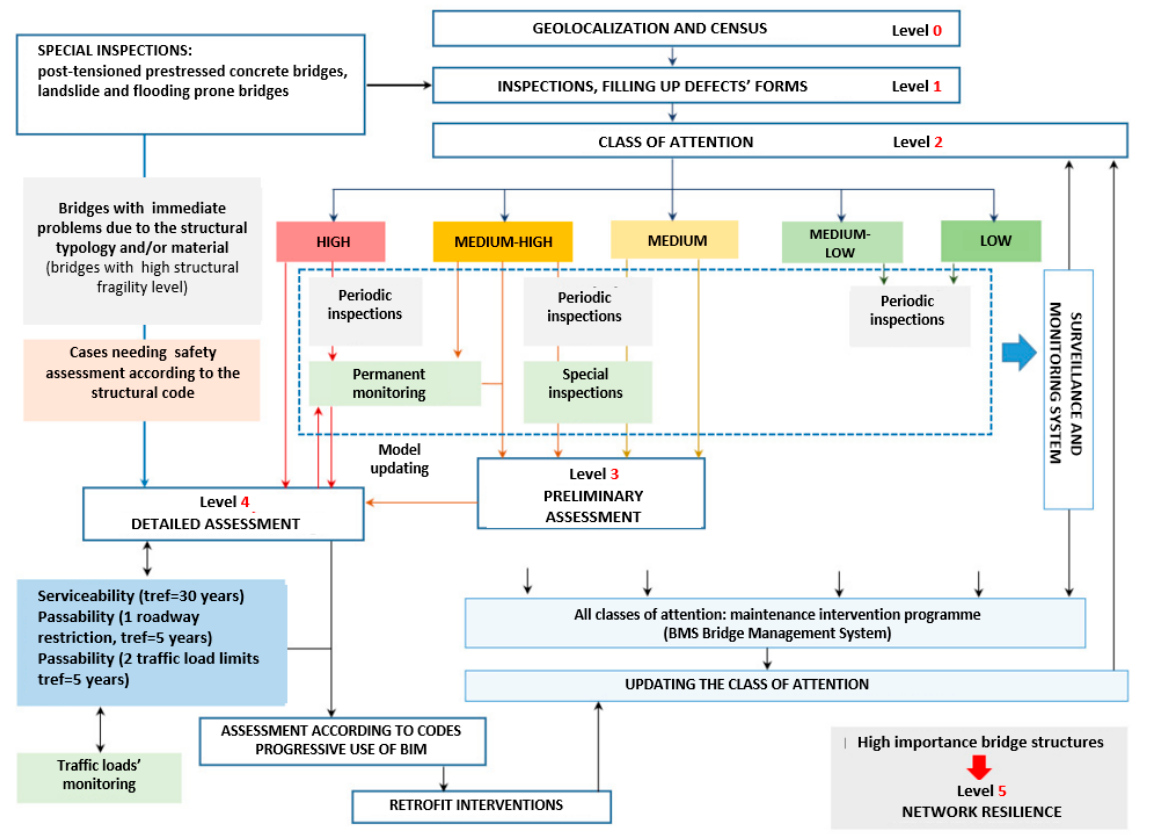
Figure 6. Multilevel approach and relationships among the different analysis levels [15].